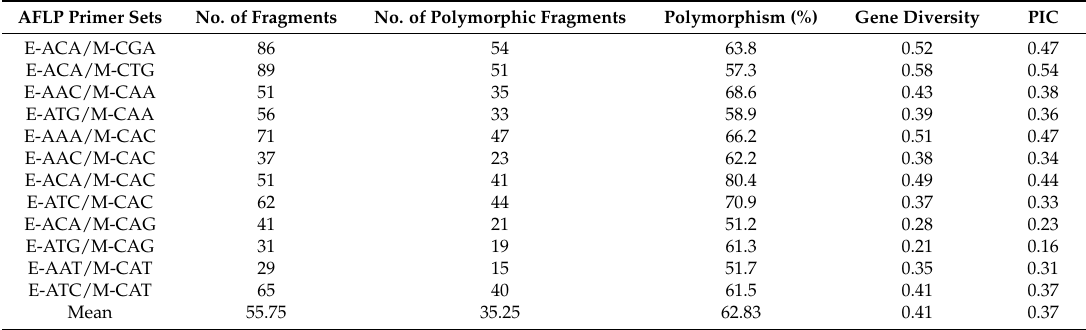
Table 2. AFLP primers sets, number of amplified fragments and diversity indices in pea accessions.